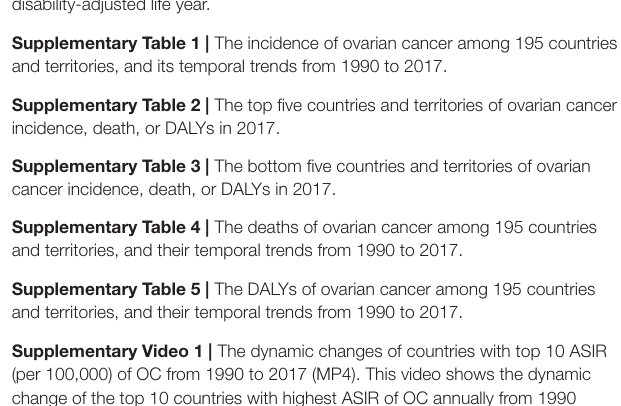
Supplementary Figure 1 | The crude prevalence cases ( × 1,000) of ovarian cancer in different GBD regions and SDI quintiles in 2017. Supplementary Figure 2 | The incidence, mortality and DALYs cases ( × 1,000) of ovarian cancer in 195 countries and territories in 2017. DALY, disability adjusted life-year. Supplementary Figure 3 | The countries with top 10 age-standardized rates (per 100,000 people) in 2017. (A) ASIR, age standardized incidence rate; (B) ASDR, age standardized death rate; (C) age-standardized DALY rate. DALY, disability adjusted life-year. Supplementary Figure 4 | The global death burden of ovarian cancer in 195 countries and territories in 2017. (A) The age-standardized death rate (per 100,000 people) of ovarian cancer in 2017; (B) the relative change in death cases between 1990 and 2017; (C) the EAPC of ovarian cancer ASDR. EAPC, estimated annual percentage change. Supplementary Figure 5 | The global DALY burden of ovarian cancer in 195 countries and territories in 2017. (A) The age-standardized DALY rate (per 100,000 people) of ovarian cancer in 2017; (B) the relative change in DALYs between 1990 and 2017; (C) the EAPC of the age-standardized DALY rate. ASDR, age-standardized death rate; EAPC, estimated annual percentage change. Supplementary Figure 6 | The proportion of different age groups in ovarian cancer by years. (A) Incidence. (B) Death. (C) DALY disability adjusted life-year. Supplementary Figure 7 | The global change in ovarian cancer incidence, death and DALYs from 1990 to 2017. DALY, disability-adjusted life year. Supplementary Figure 8 | The global change in age-standardized incidence, death, and DALYs rates of ovarian cancer from 1990 to 2017. DALY, disability-adjusted life year. Supplementary Table 1 | The incidence of ovarian cancer among 195 countries and territories, and its temporal trends from 1990 to 2017. Supplementary Table 2 | The top five countries and territories of ovarian cancer incidence, death, or DALYs in 2017. Supplementary Table 3 | The bottom five countries and territories of ovarian cancer incidence, death, or DALYs in 2017. Supplementary Table 4 | The deaths of ovarian cancer among 195 countries and territories, and their temporal trends from 1990 to 2017. Supplementary Table 5 | The DALYs of ovarian cancer among 195 countries and territories, and their temporal trends from 1990 to 2017. Supplementary Video 1 | The dynamic changes of countries with top 10 ASIR (per 100,000) of OC from 1990 to 2017 (MP4). This video shows the dynamic change of the top 10 countries with highest ASIR of OC annually from 1990 to